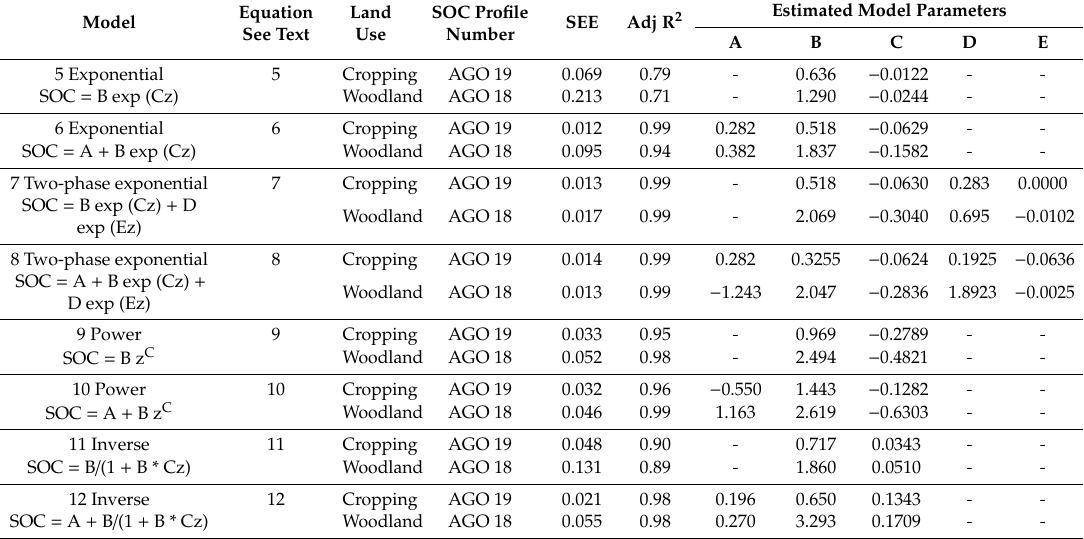
Table 4. Mathematical models of the depth [z cm] distribution of SOC for each of a set of paired sites on Grey Vertosols on the Darling Riverine Plain in north Western NSW [AGO sites 18 and 19]. Example of goodness of fit of functions and influence of land use [cropping versus woodland]. Graphs for these are shown in Figure 4. “–“ indicates that the parameter does not occur in the model. Equation numbers refer to Equations in text and Table